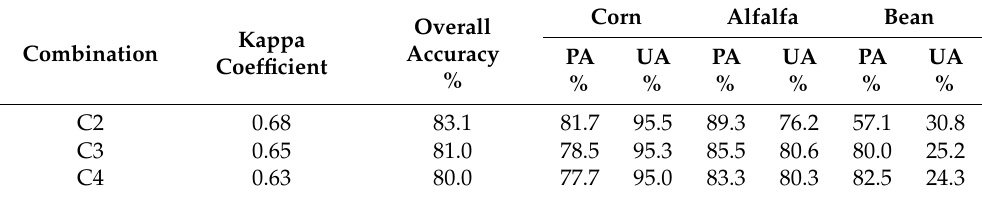
Table 11. Results of the classification on 21 May in the 2020 agricultural cycle.